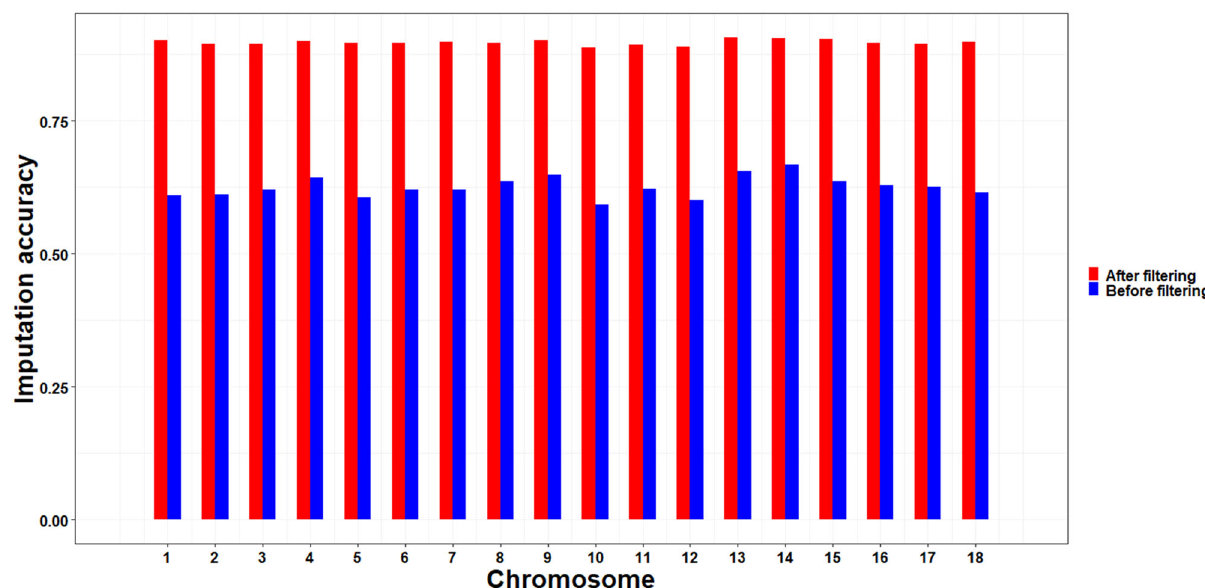
Fig. 1 Imputation accuracy for each chromosome in Yorkshire pigs. Accuracy of imputation based on Beagle R 2 before and after fi ltering (Beagle R 2 < 0.8). “ Before fi ltering ” for the blue part, “ After fi ltering ” for the red part.